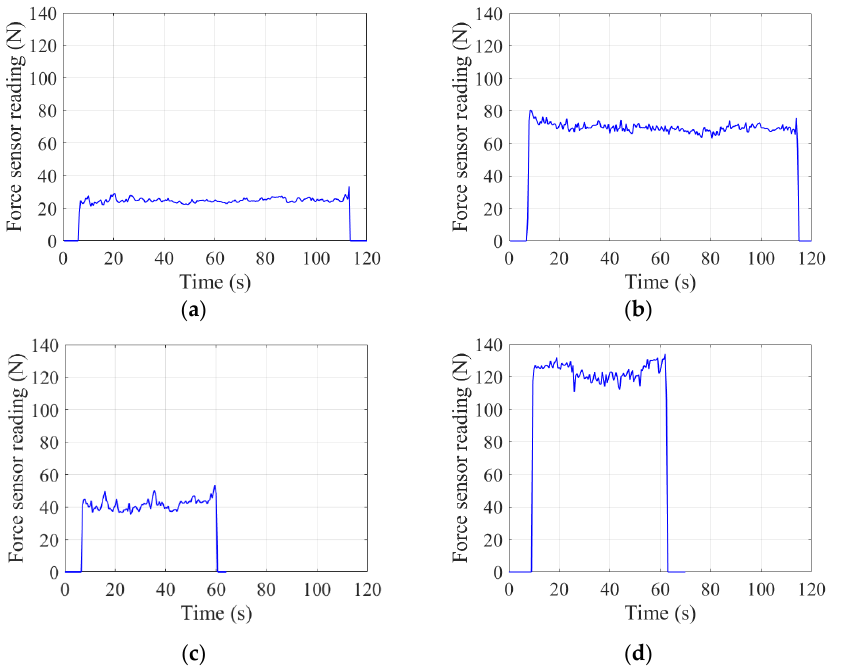
Figure 17. The force sensor readings of the smart tool holder at the working condition of constant feed rate ( f ) and cutting depth ( ap ): ( a ) f = 0.1 mm/rev, ap = 0.1 mm; ( b ) f = 0.1 mm/rev, ap = 0.3; ( c ) f = 0.2 mm/rev, a p = 0.1 mm; and ( d ) f = 0.2 mm/rev, a p = 0.3 mm. The spindle rotates at 500 rpm and the cut length is 90 mm.